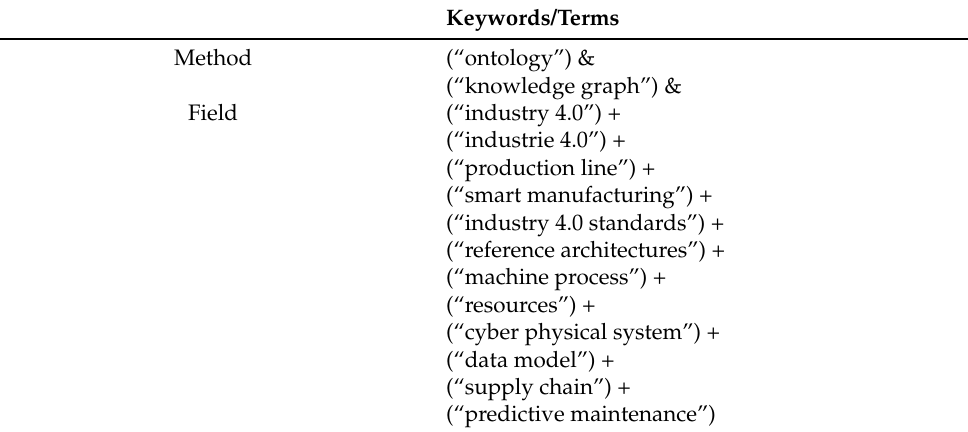
Table 1. Identification of search keywords.